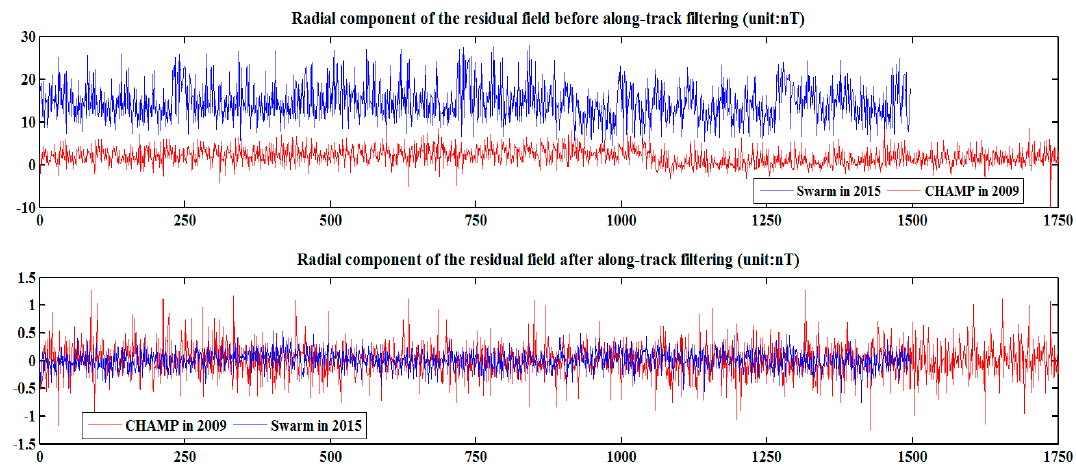
Figure 4. Z component of the residual field before and after correction of the CHAMP (in 2009) and Swarm (in 2015) satellite data. We used the MF7 model to remove the lithospheric field for this illustration.